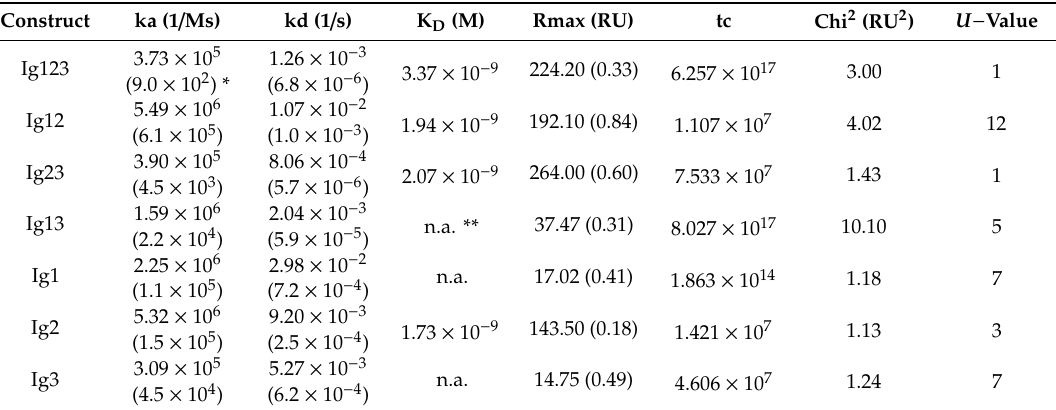
Table 1. Summary of kinetic